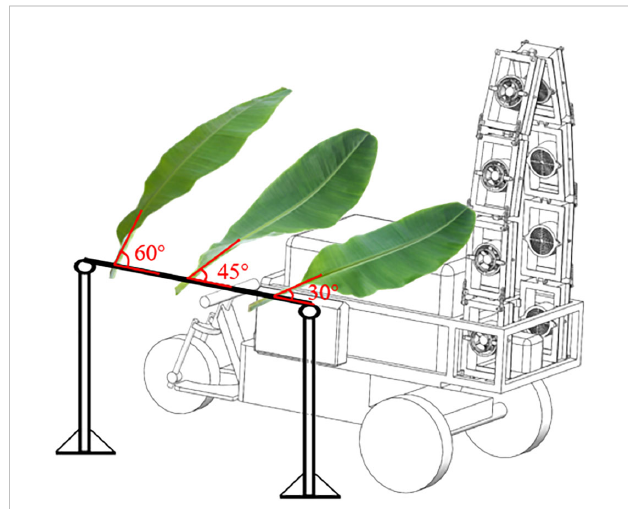
FIGURE 1 Schematic diagram of the experimental site.